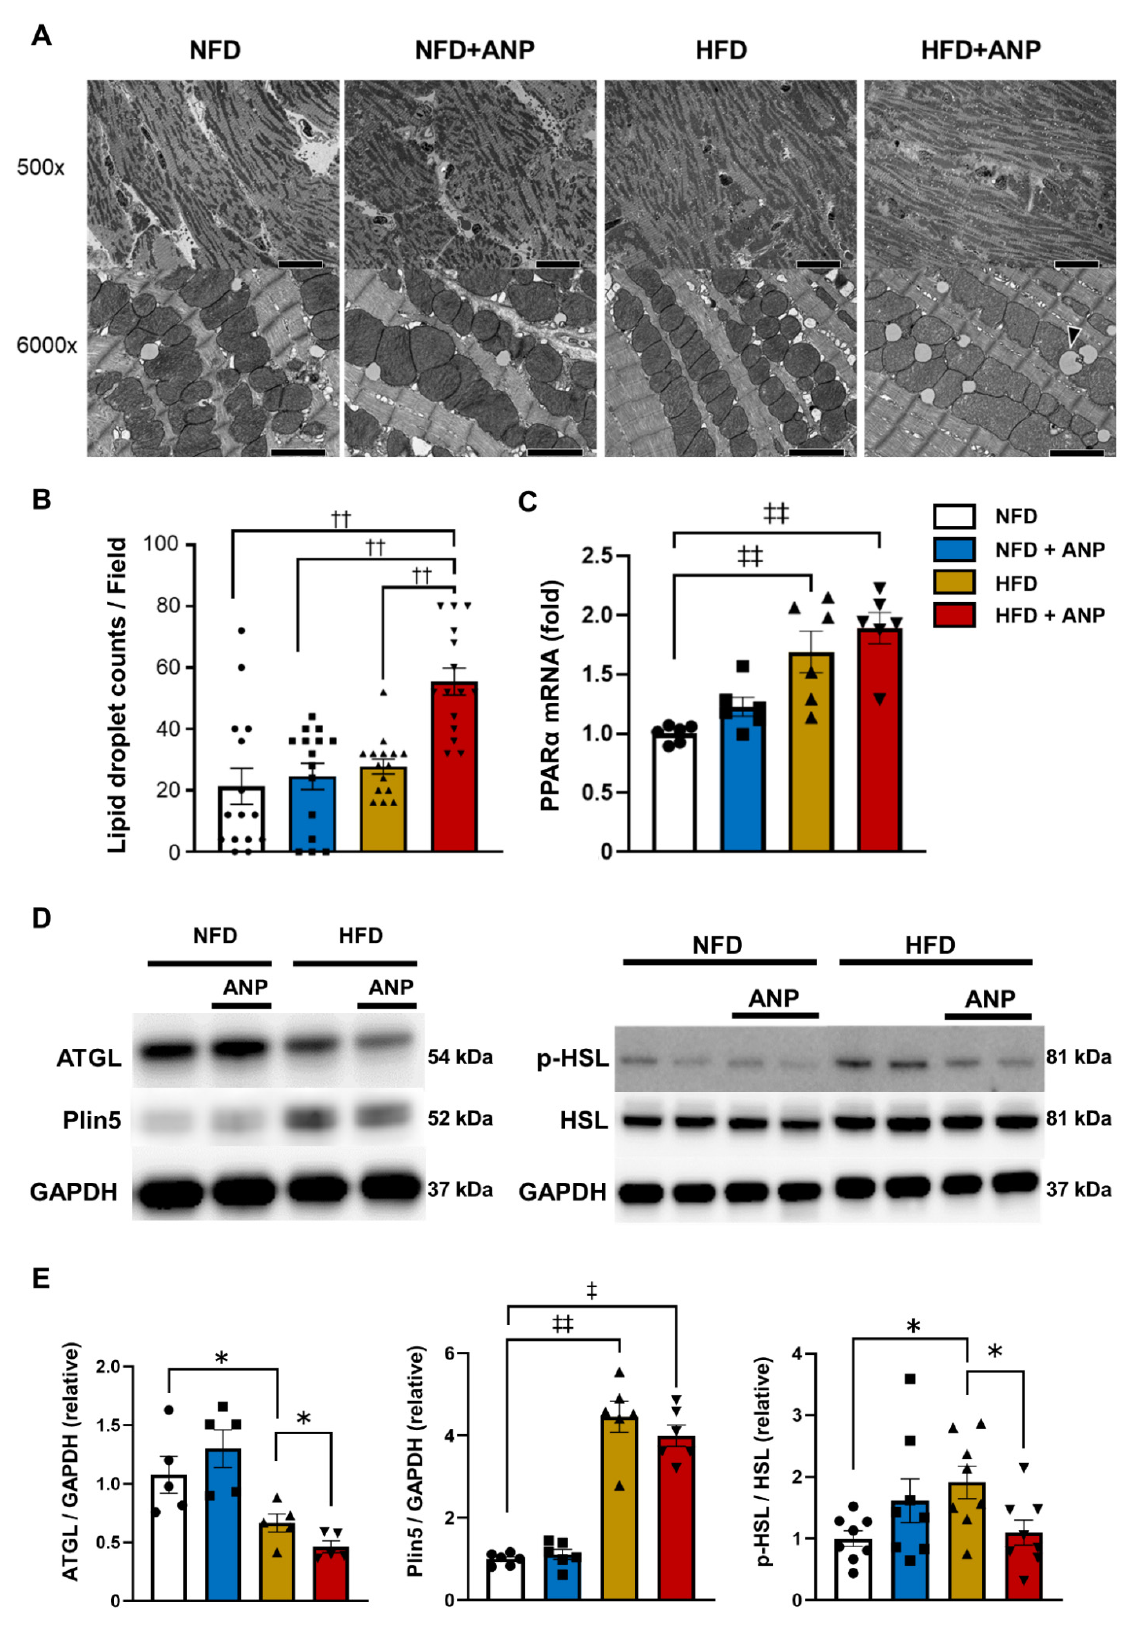
Figure 5. Myocardial microstructure and LD regulatory protein expression in vivo. ( A ) Represen- tative electron micrographs of heart sections before IRI with or without ANP. Each pair of